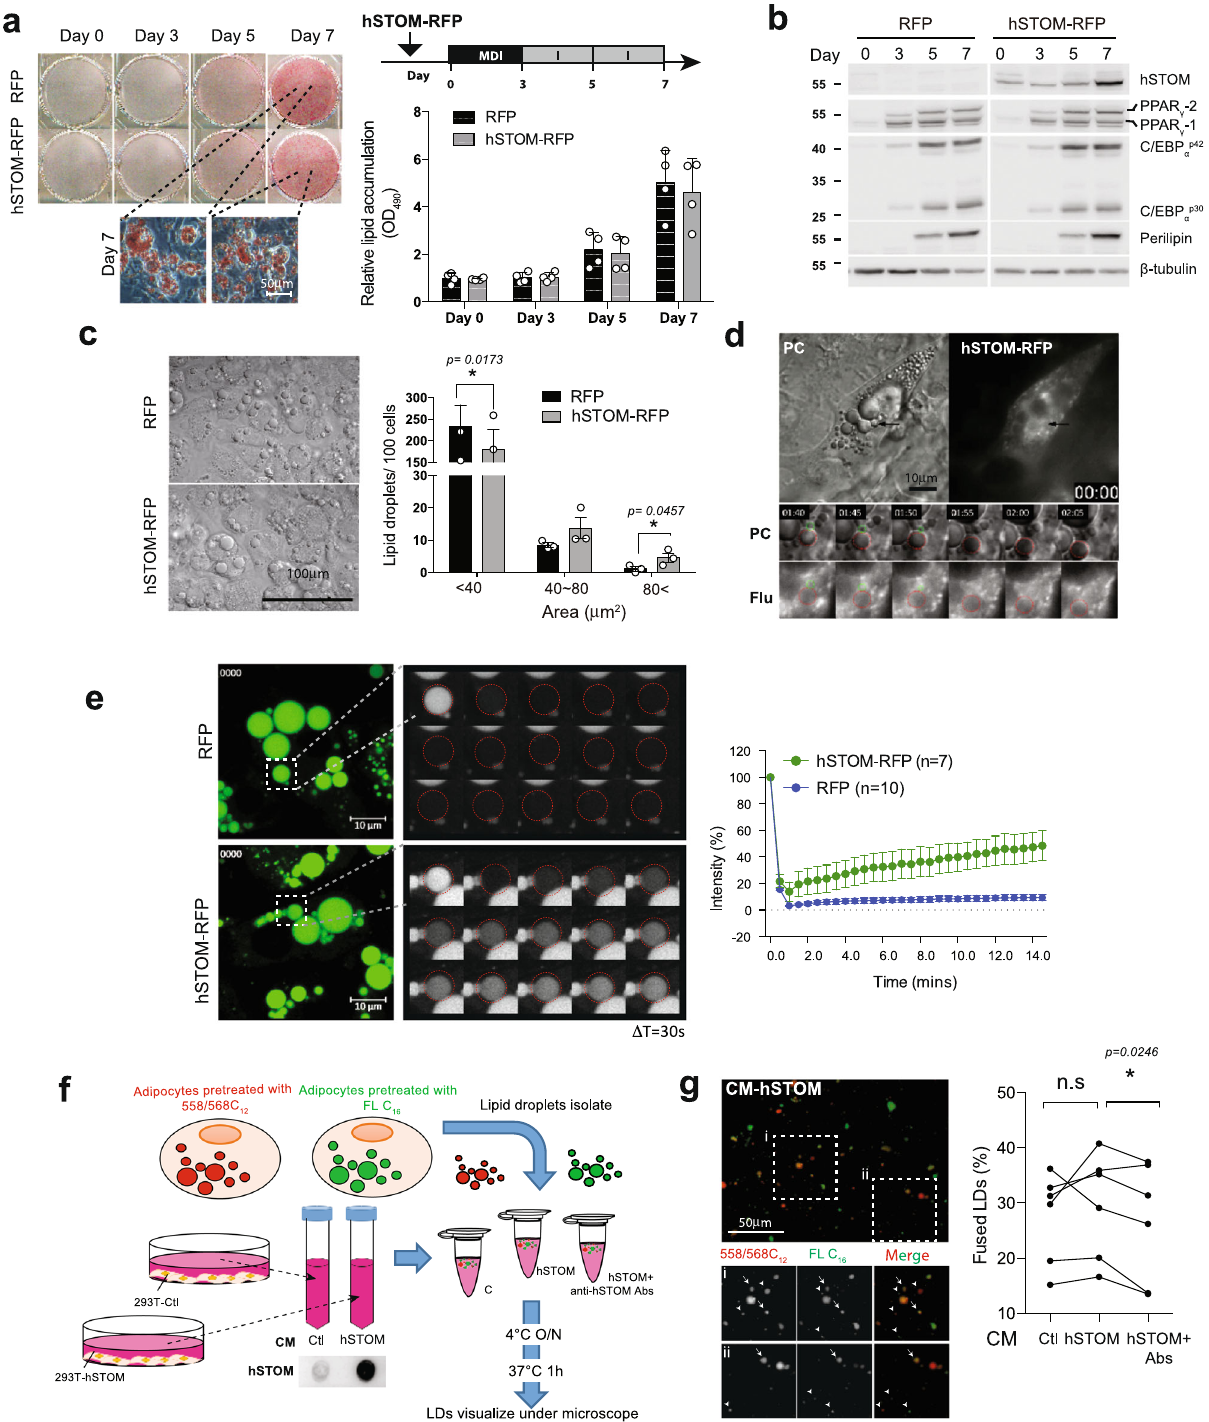
palmitic acid (PA) for 15 min, most of the LD-associated stomatin proteins seemed to “ dissociate ” from LDs and appeared on the plasma membrane or became dispersed in the cytosol. The amount of membrane proteins located on the cell surface could be labeled using surface biotinylation methods and separately quanti fi ed from the proteins present inside the cell. As shown in Fig. 3d, the biotinylated portions on the surface (surface), relative to the total protein (input) of stomatin, CAV-1, CD36, and ATP1A1 were calculated. Actin proteins that present